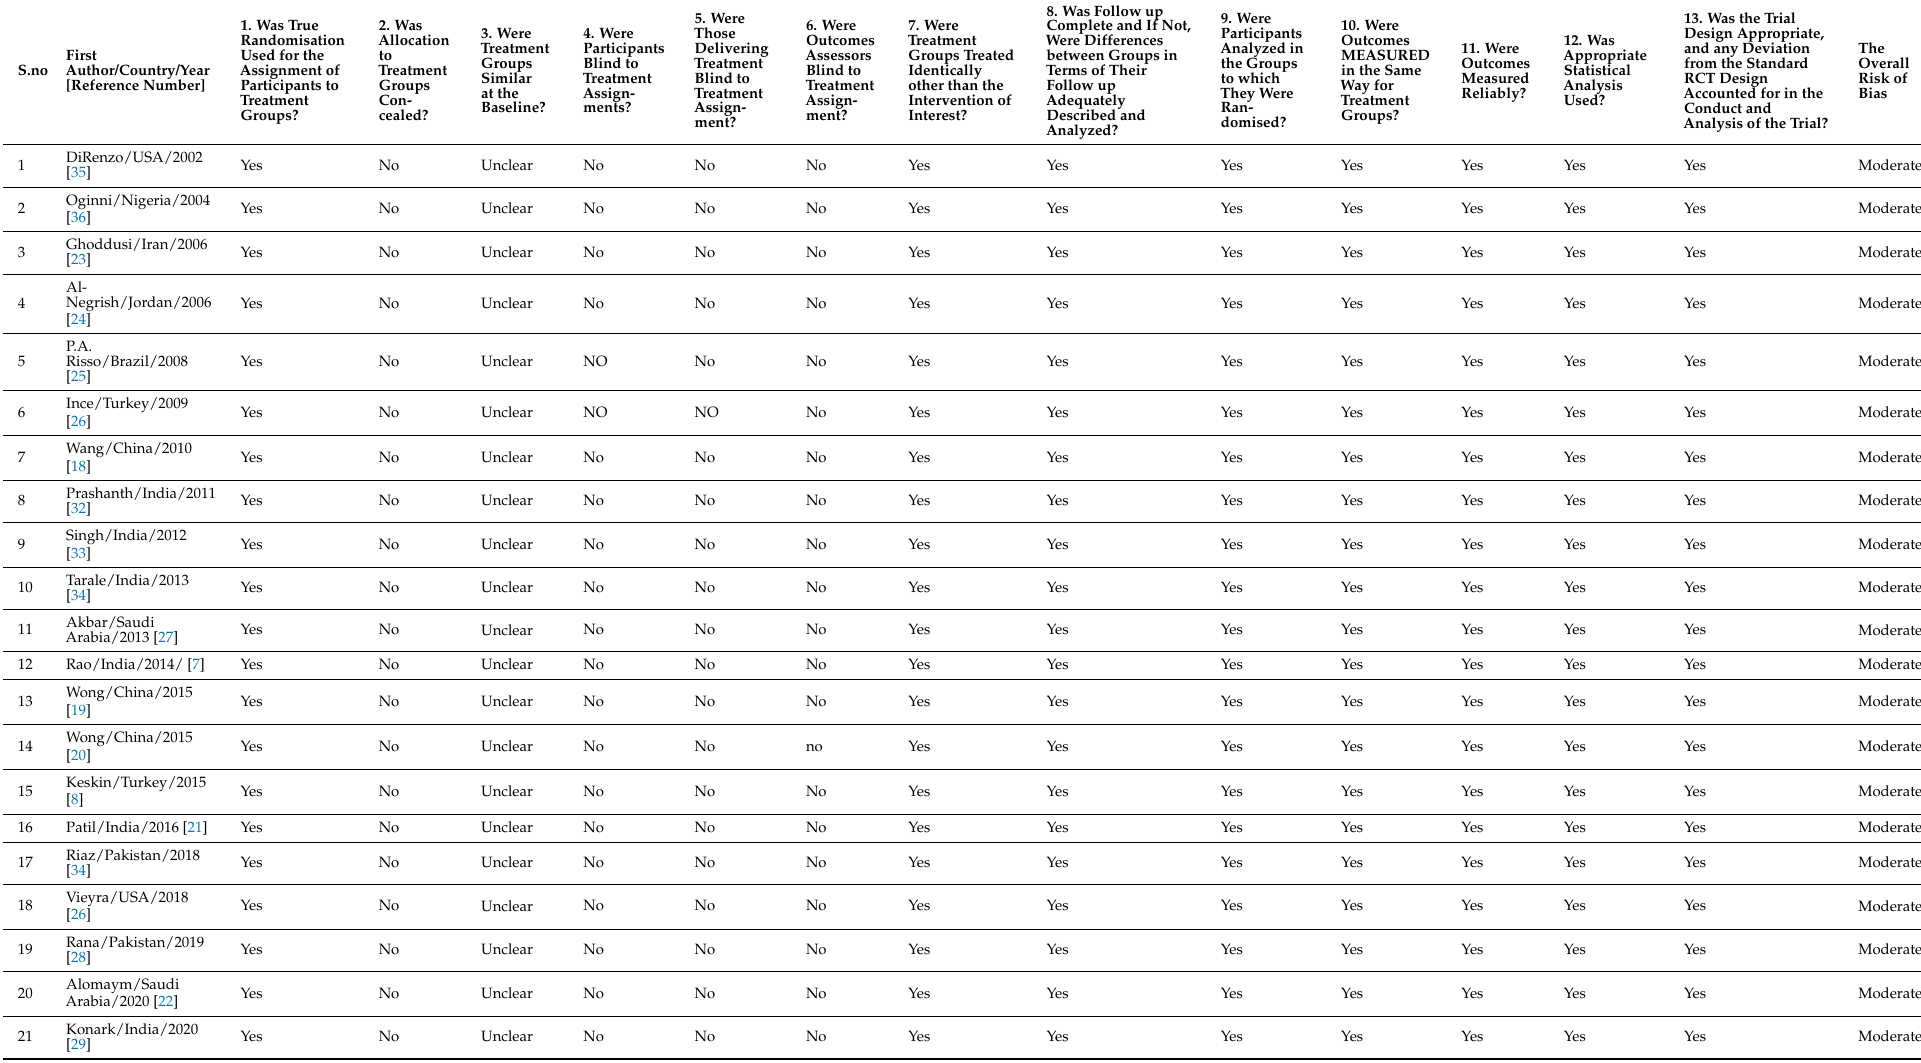
Table 2. The Joanna Briggs Institute (JBI) Critical Appraisal Checklist for randomised controlled trials to assess the risk of bias for the included